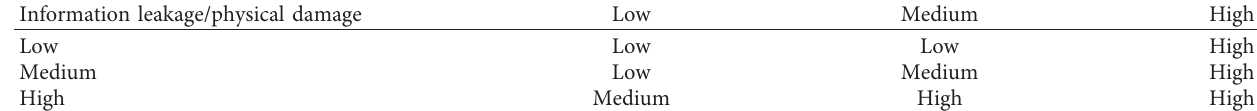
Table 3: Combined severity level matrix (adapted from